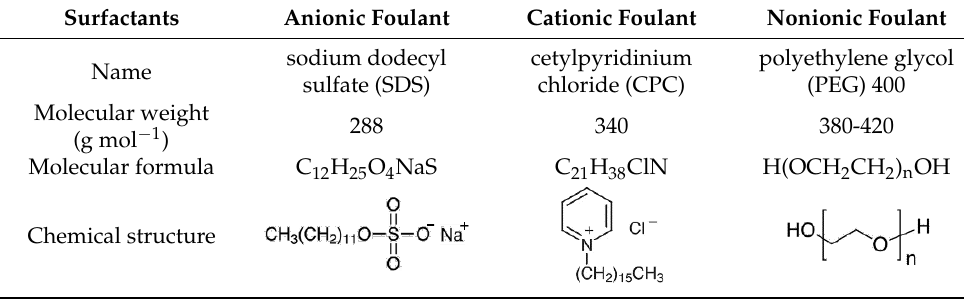
Table 2. Summary of surfactants as foulants used in this study.